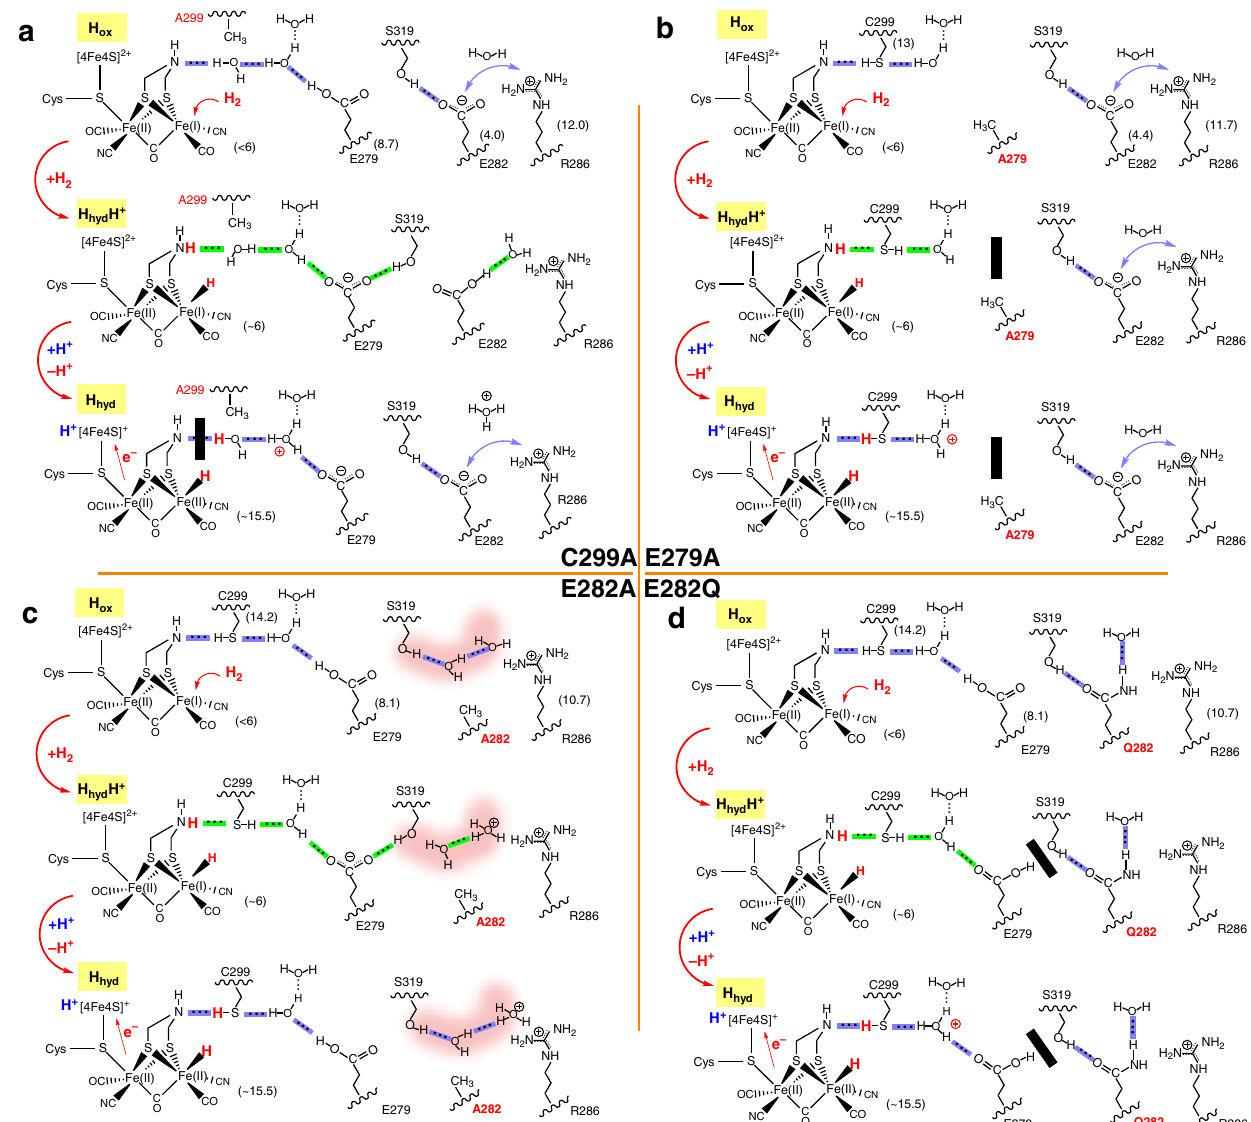
Fig. 6 In fl uence of SDM on the proton transfer mechanism during H 2 -uptake in CpI. Effects of SDM on the proposed proton transfer mechanism for selected CpI variants: C299A ( a ), E279A ( b ), E282A ( c ), and E282Q ( d ). H 2 -binding induces a shift in the H-bond pattern (from mode 1 to mode 2) and initiates the catalytic mechanism during which the H-bond pattern repeatedly shifts between modes 1 (blue) and 2 (green) while promoting a stepwise proton release via the PT pathway (for details see Supplementary Fig. 9 + 14). The p Ka values of adt-ligand at different redox states are derived from previous studies 49,58 . The mutated residues and hydrogen atoms from substrate were highlighted as red. The green double arrow indicates a putative salt bridge contact. In c (E282A), the pink shading area indicates a slowed-down but still functioning proton transfer. Protons presented in blue close to the [4Fe] H sub-cluster originate from the recently described regulatory PT pathway 34,59,60 , which is independent of substrate/product